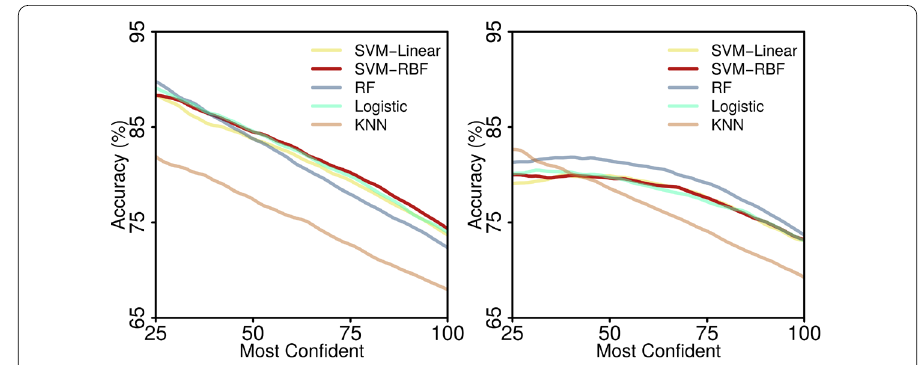
Figure 4 Accuracy in EU (left), SA (right) on the top x% of the users the algorithms are the most confident about . In EU accuracy scales linearly with the top x% of the dataset while in SA most algorithms plateau around the top 60% of the database.